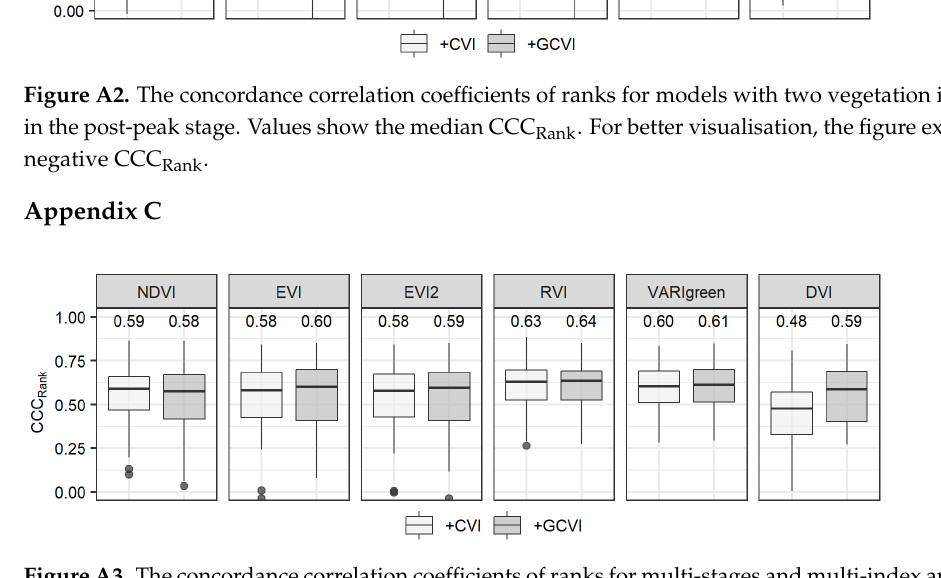
Figure A3. The concordance correlation coefficients of ranks for multi-stages and multi-index analysis. Values show the median CCC Rank for each treatment. For better visualisation, the figure excluded negative CCC Rank